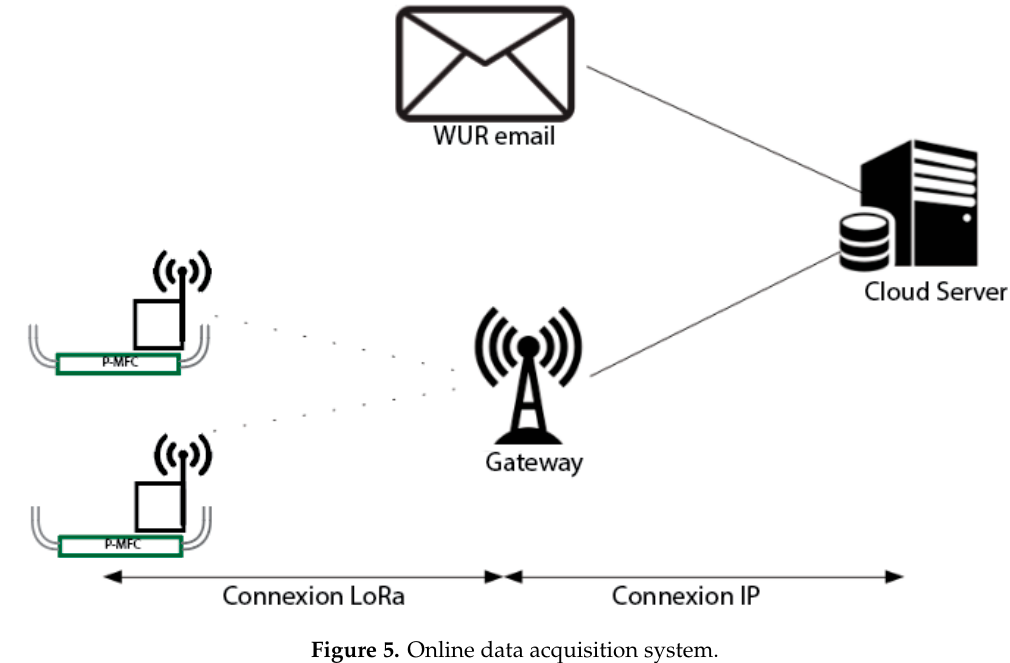
Figure 5. Online data acquisition system.